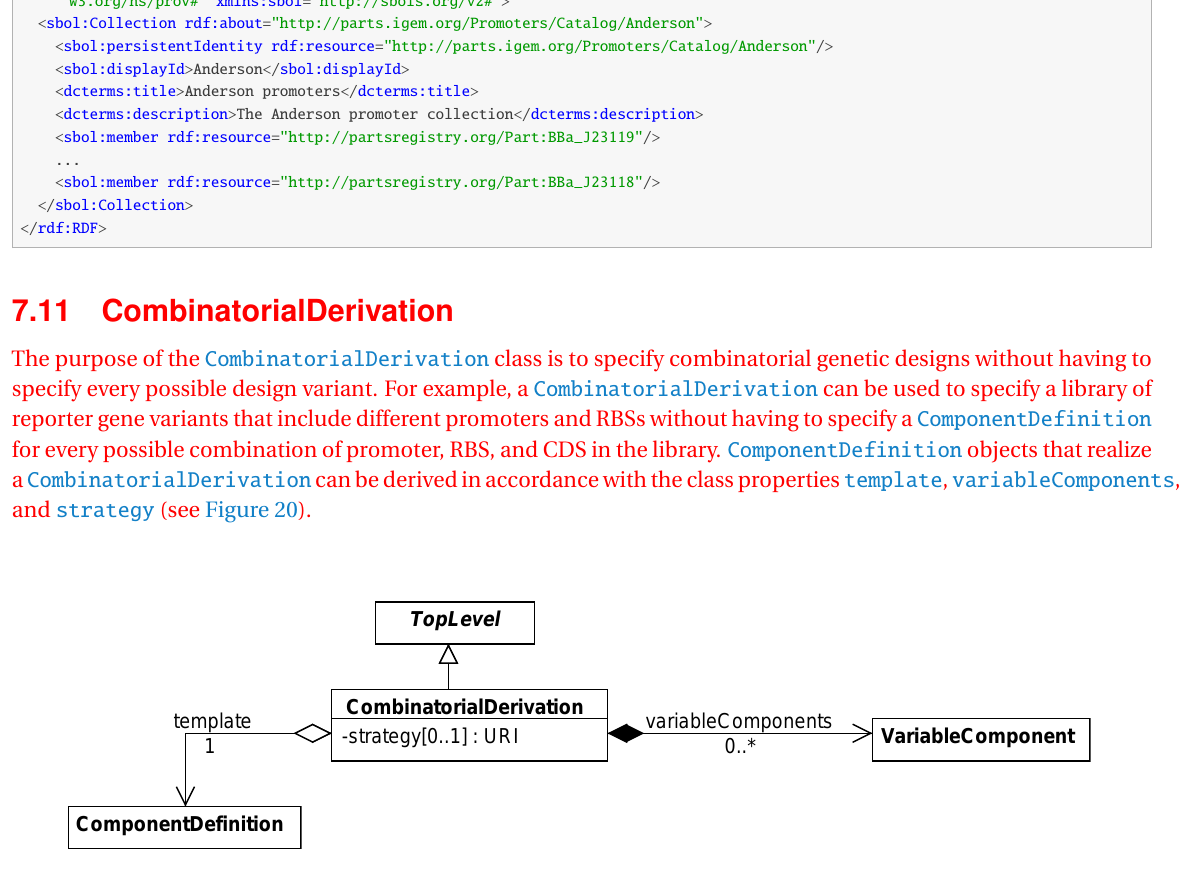
Figure 20: Diagram of the CombinatorialDerivation class and its associated